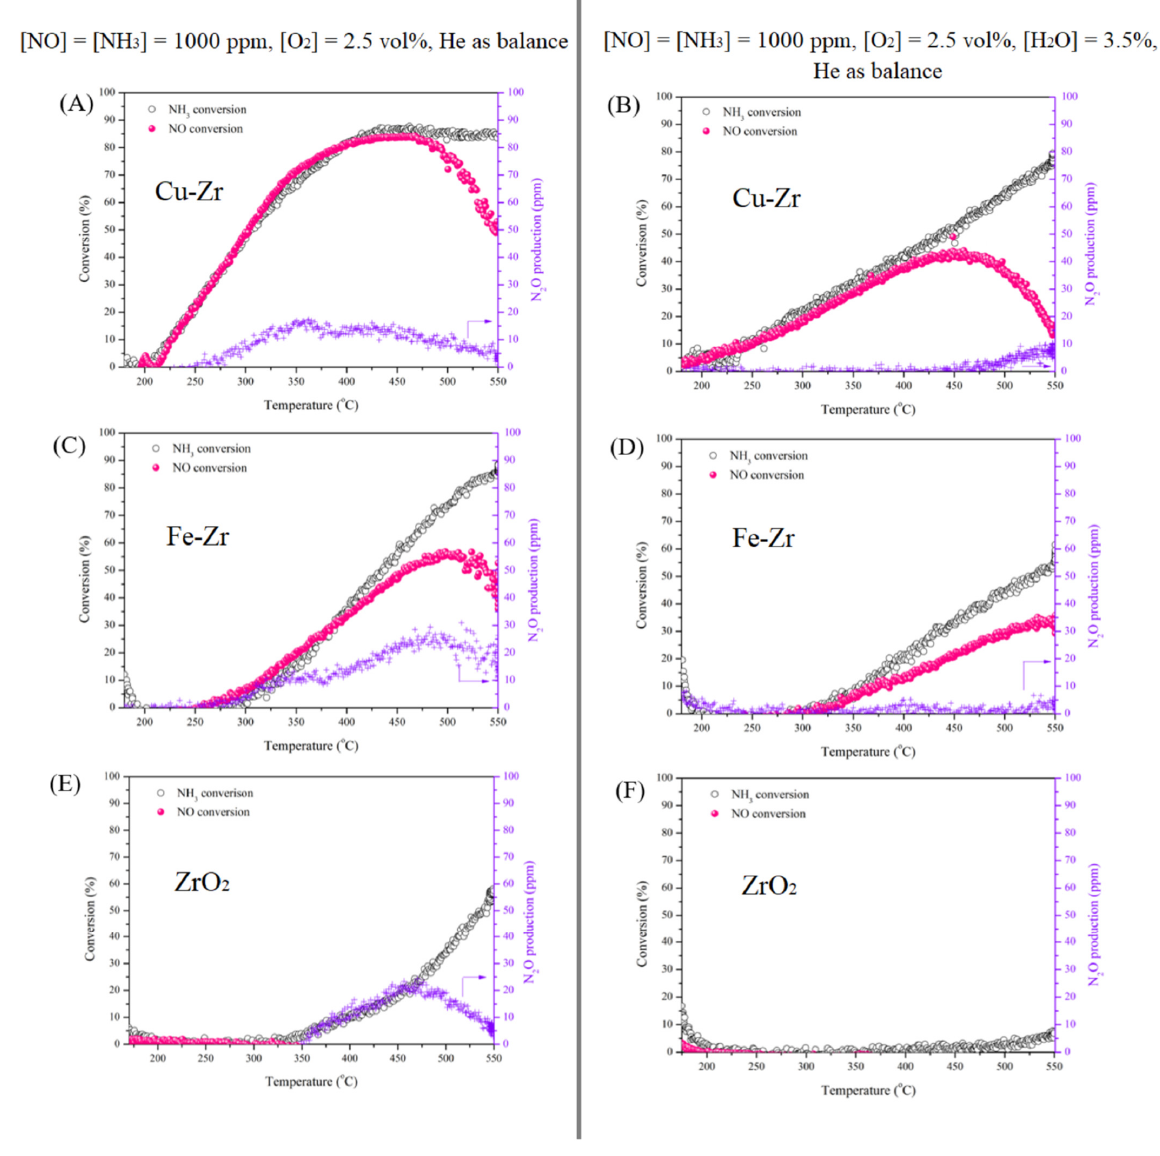
Figure 4. NO and NH 3 conversion profiles and N 2 O production as a function of temperature in NH 3 -SCR over Cu-Zr catalyst ( A ) in absence of water, ( B ) in presence of water; Fe-Zr catalyst ( C ) in absence of water, ( D ) in presence of water; and ZrO 2 support ( E ) in absence of water, ( F ) in presence of water. The experimental conditions: [NO] = 1000 ppm, [NH 3 ] = 1000 ppm, [H 2 O] = 3.5 vol% when used, [O 2 ] = 2.5 vol% diluted in helium; total flowrate of 100 mL/min.